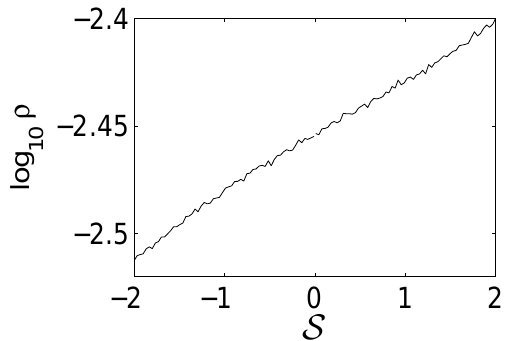
Figure 5. Logarithm of the edge density ρ for gamma-distributed white noise in dependence on the associated skewness S (time se- ries length T = 1667 as for the sunspot data, ensemble averages over 50 independent realizations).